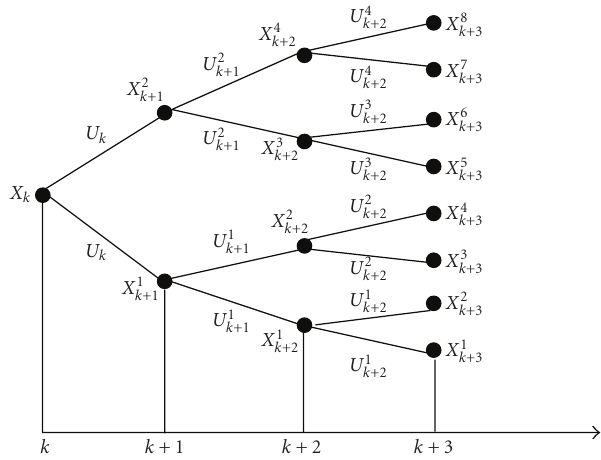
Figure 1: Tree trajectory with L = 2 and N = 3 in the x ∈ R 2 state